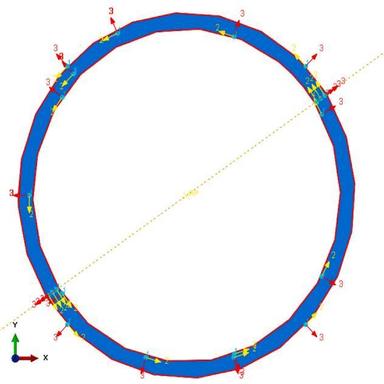
Material orientation defined for the tube.